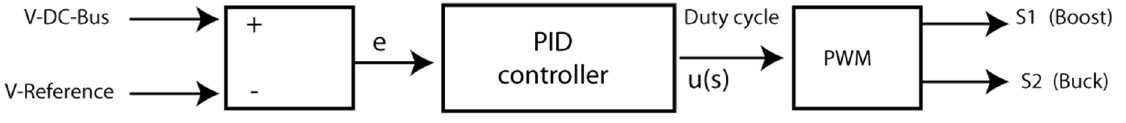
Figure 10. Schema of the PID controller implementation.